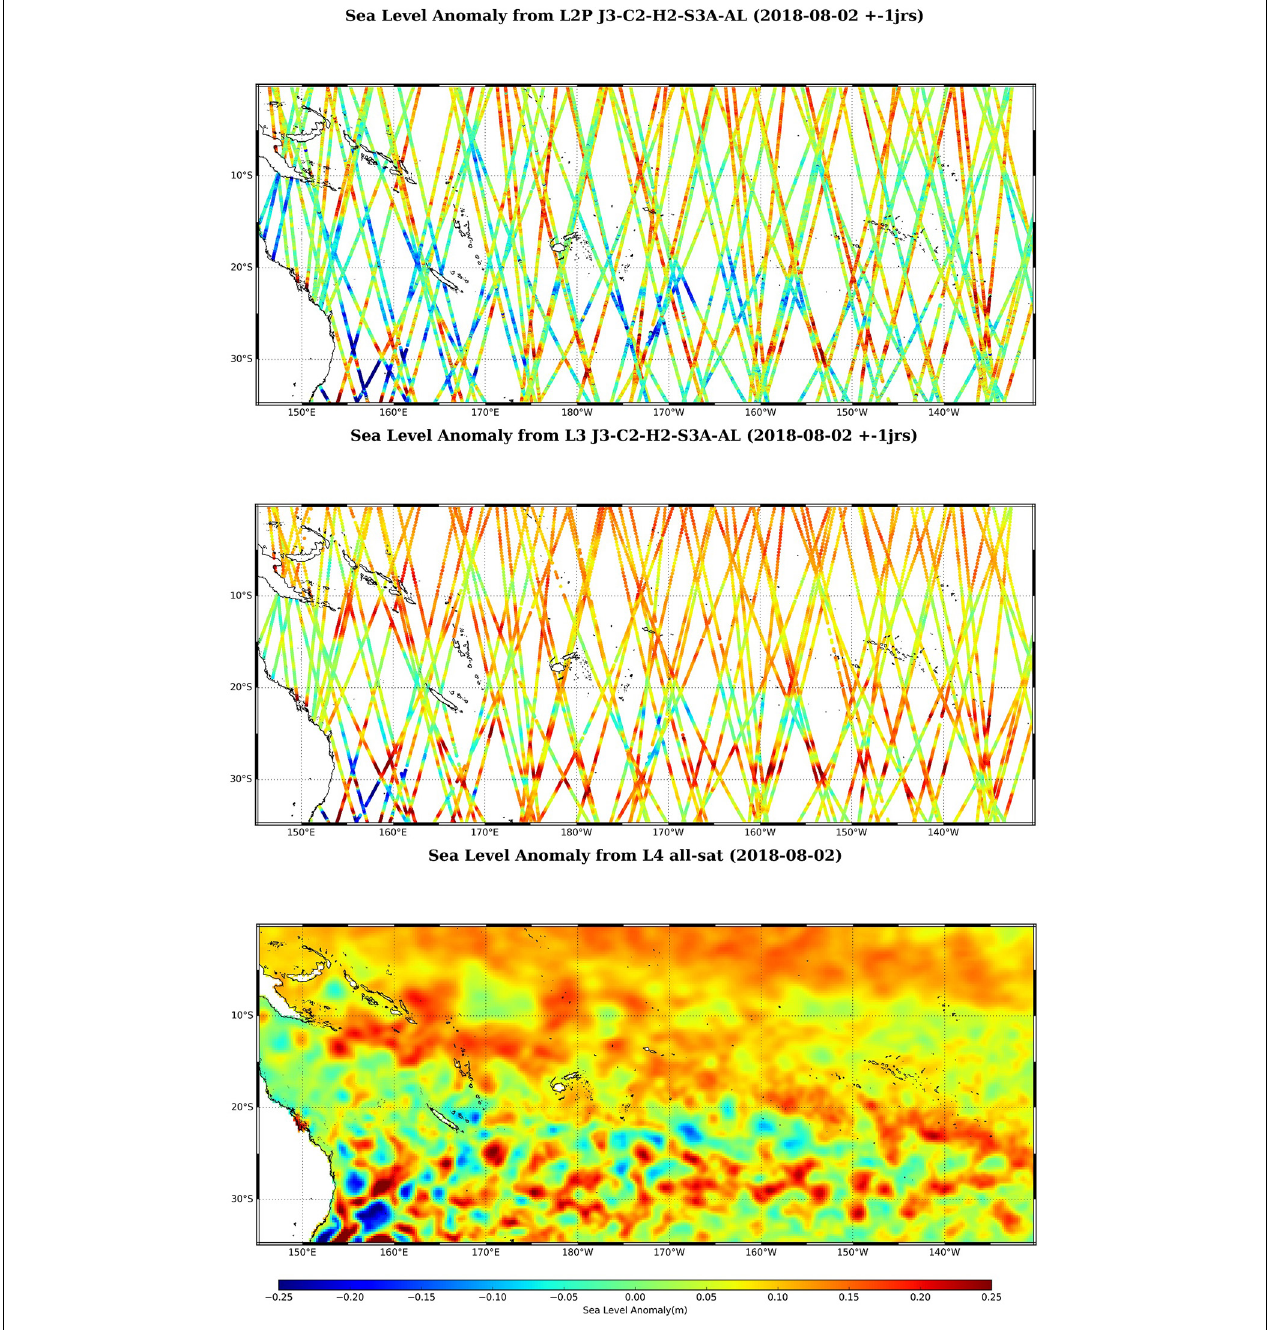
FIGURE 3 | Sea level anomalies L2P input data processed by the DUACS production system from Jason-3, CryoSat-2, HY-2A, Sentinel-3A, and SARAL/AltiKa missions on 02/08/2028 ( ± 1 day) in the South-West Pacific Ocean (top). The corresponding along-track cross-calibrated L3 and merged L4 data are shown in the middle and bottom panels,